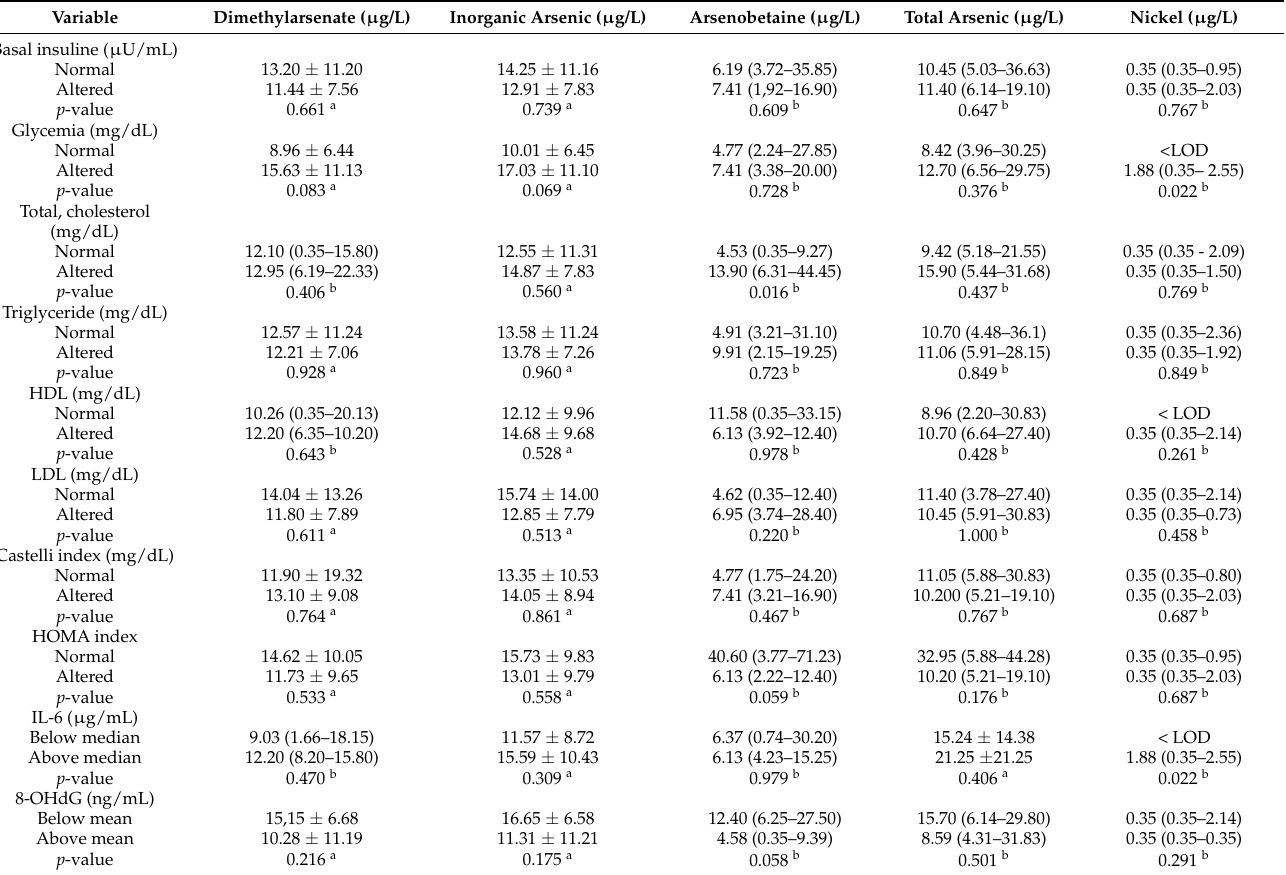
Table 2. Differences in heavy metal concentrations on people with normal vs. altered biochemical and biomarkers levels.